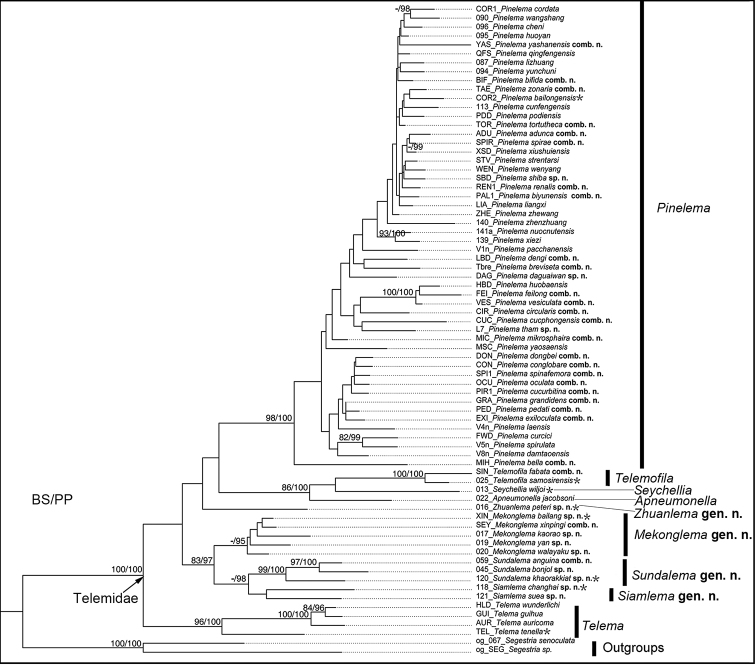
Maximum likelihood tree of Asian Telemidae. Each genus is indicated by black bar or solid line. BS < 70 and PP < 95 are not shown, taxa followed by an asterisk indicate the type species of the corresponding genus. BS: bootstrap support; PP: posterior possibility.